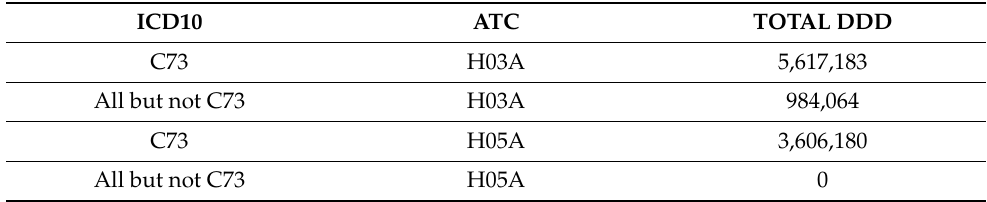
Table 6. Analysis of DDDs for thyroid preparations (H03A) and parathyroid hormones (H05A).